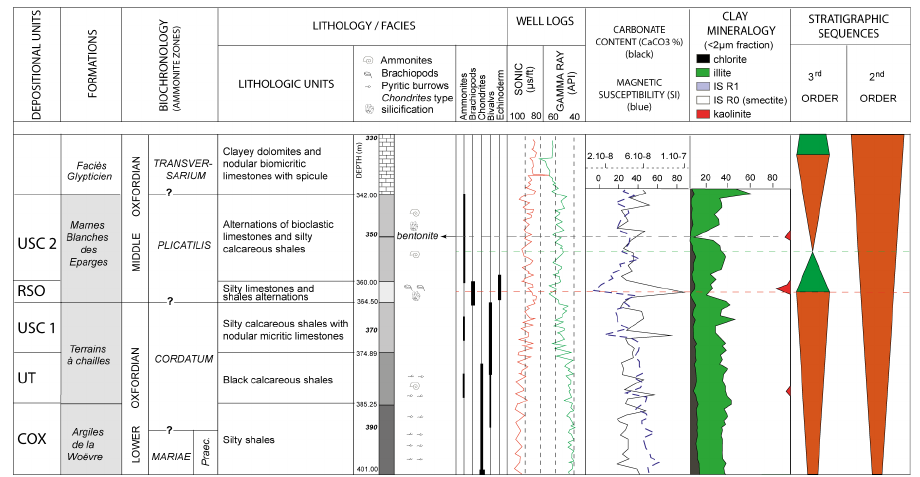
Figure 3. Lithological and sequence stratigraphic evolution of Lower and Middle Oxfordian deposits in the Bure area (adapted with permission from [13 – 16].